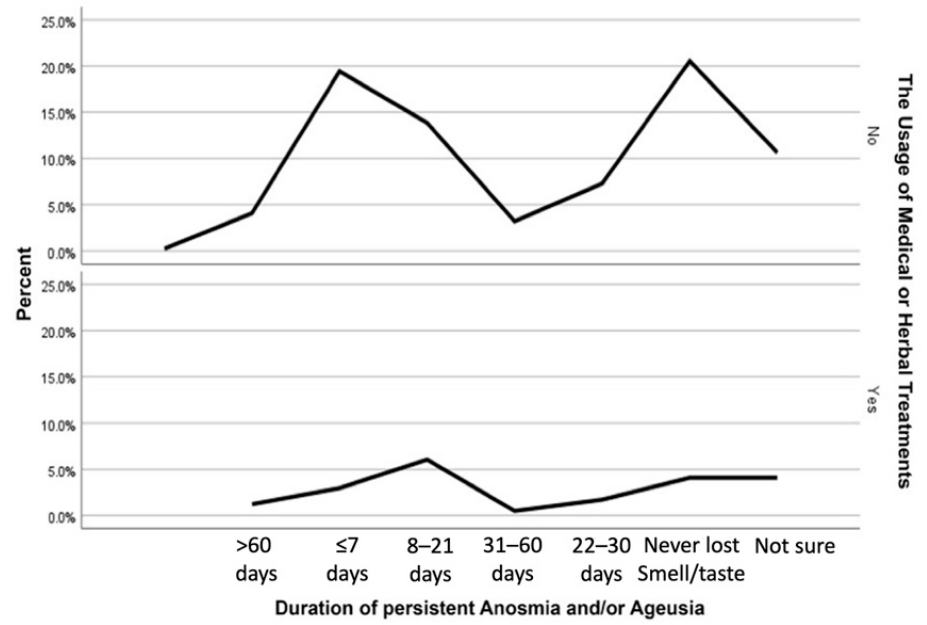
Figure 2. The association between the use of treatments and the duration of persistent anosmia and/or ageusia ( p = 0.002).